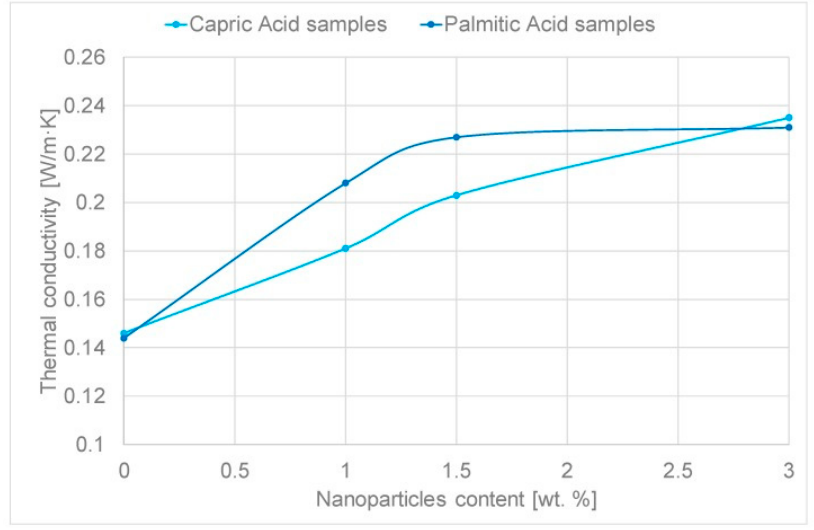
Figure 8. Figure 8. Increase in thermal conductivity of capric and palmitic acid with increase in CuO nano- particles [50].